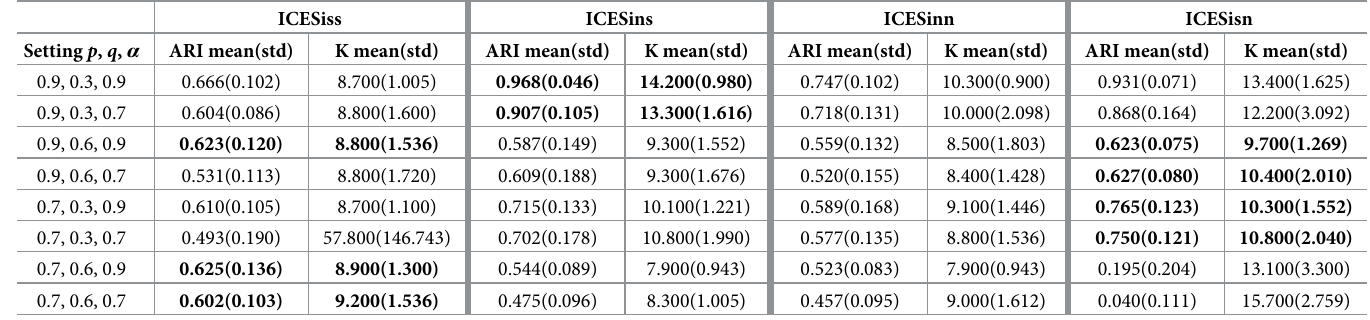
Table 15. The performance of ICESi methods at medium-size networks with quantitative features at the nodes; with selected data pre-processing for each algorithm: The average ARI index and its standard deviation over 10 different data sets. ICESiss ICESins ICESinn ICESisn